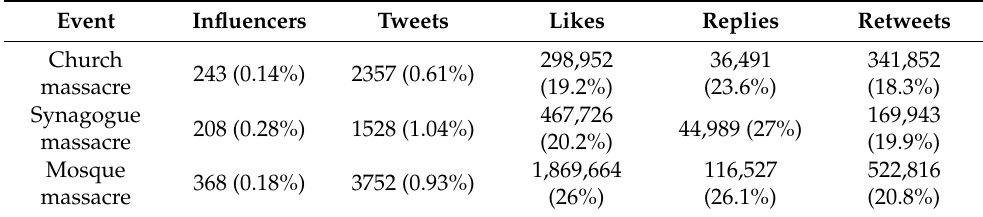
Table 3. Role of influencers in the discussion.